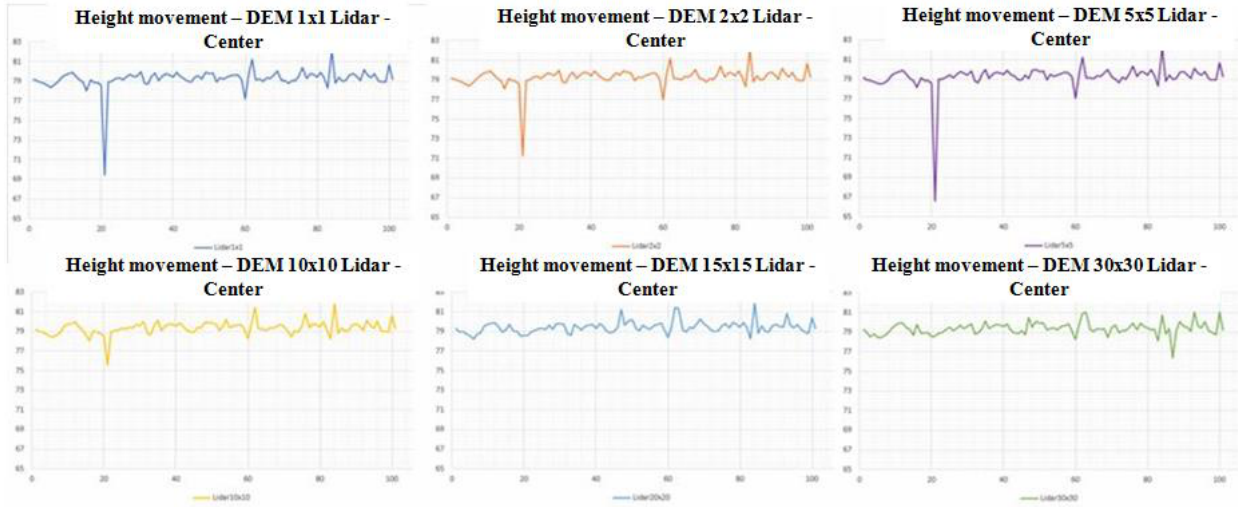
Figure 10. Divided graphs of the movement of height values.